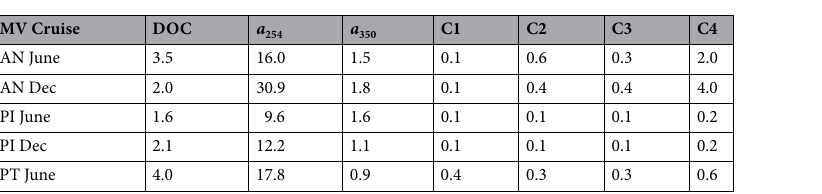
Table 3. Production of dissolved organic carbon (DOC, mmol L −1 ), chromophoric DOM (as a 254 and a 350, m −1 ) and fluorescent components (C1 to C4, RU) in the pore water sediments of Anastasya (AN), Pipoca (PI) and St. Petersburg (PT) during June and December 2016. The net increase is indicated (= value bottom depth pore water − value bottom